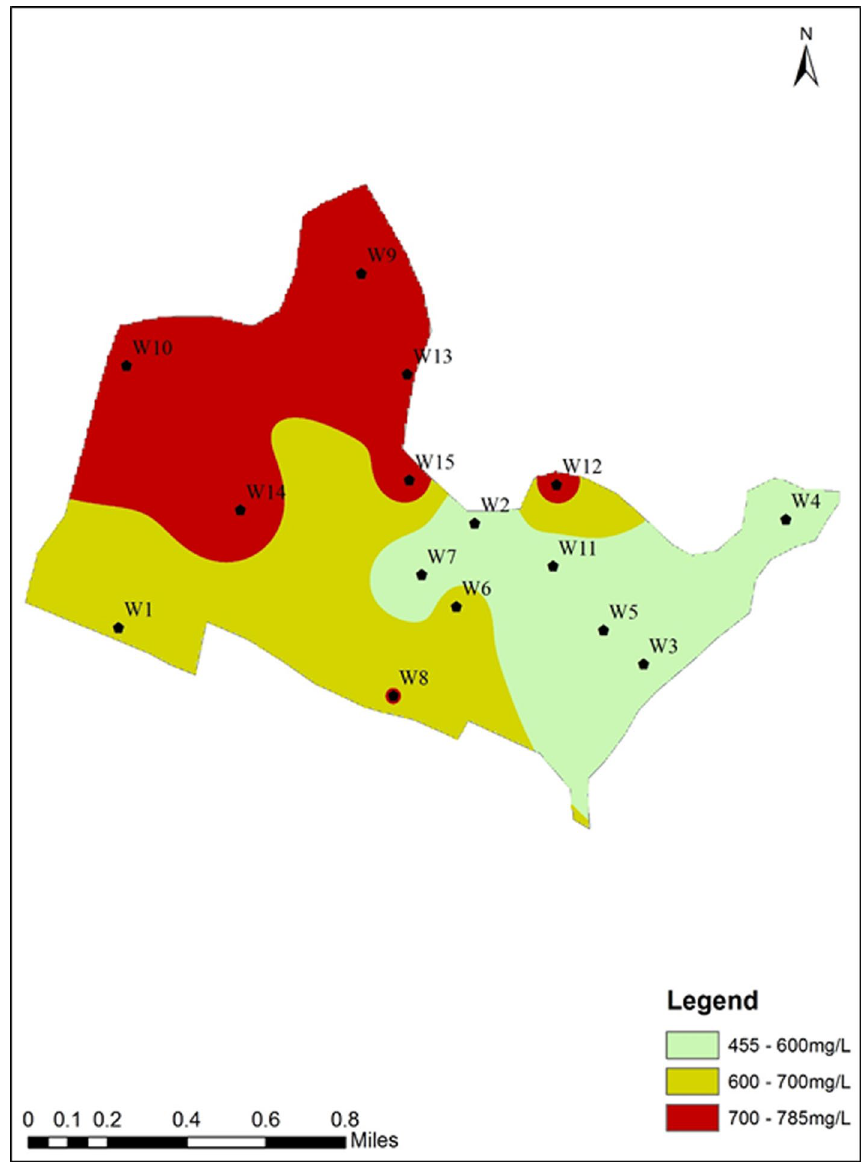
Fig. 3 The spatial interpolation of total hardness concentration in the study